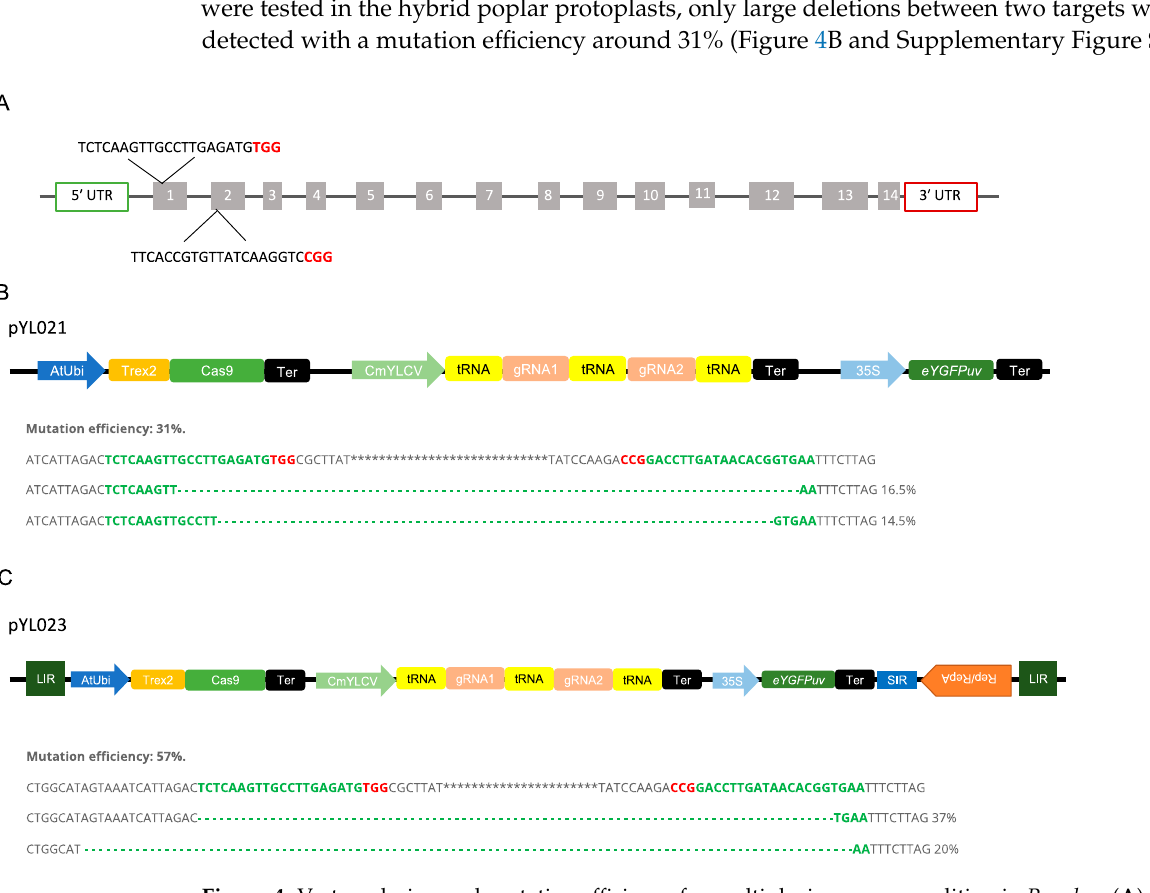
Figure 4. Vectors design and mutation efficiency for multiplexing genome editing in Populus . ( A ) Target regions of the Phytoene desaturase (PDS) gene and sequences of two gRNAs . Bold red charac- ters represent PAM sequences. ( B ) Vector design for pYL021 and mutation efficiency determined by NGS in P. trichocarpa × P. deltoides (clone 52-225) protoplast. Red characters represent PAM se- quences and dash lines represent deletions. ( C ) Vector design for pYL023 and mutation efficiency determined by NGS in P. trichocarpa × P. deltoides (52-225) protoplast. Red characters represent PAM sequences and dash lines represent deletions. LIR, large intergenic region; SIR, short intergenic re- gion; Rep, replication-initiation protein; tRNA , 77-bp pre- tRNA Gly gene; CmYLCV , Cestrum yellow leaf curling virus promoter; AtUbi , Arabidopsis ubiquitin promoter; Trex2 ; the three prime repair exonu- clease 2 exonuclease; Ter ; terminator; 35S; Cauliflower mosaic virus (CaMV) 35S promoter.